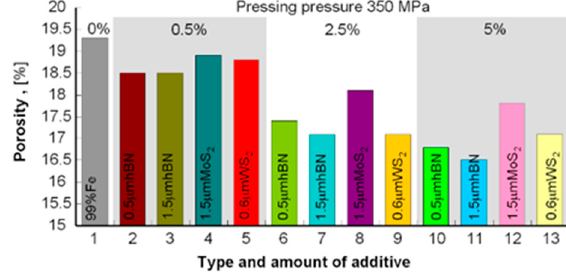
Figure 2. Sample porosity after pressing 350 MPa and sintering.